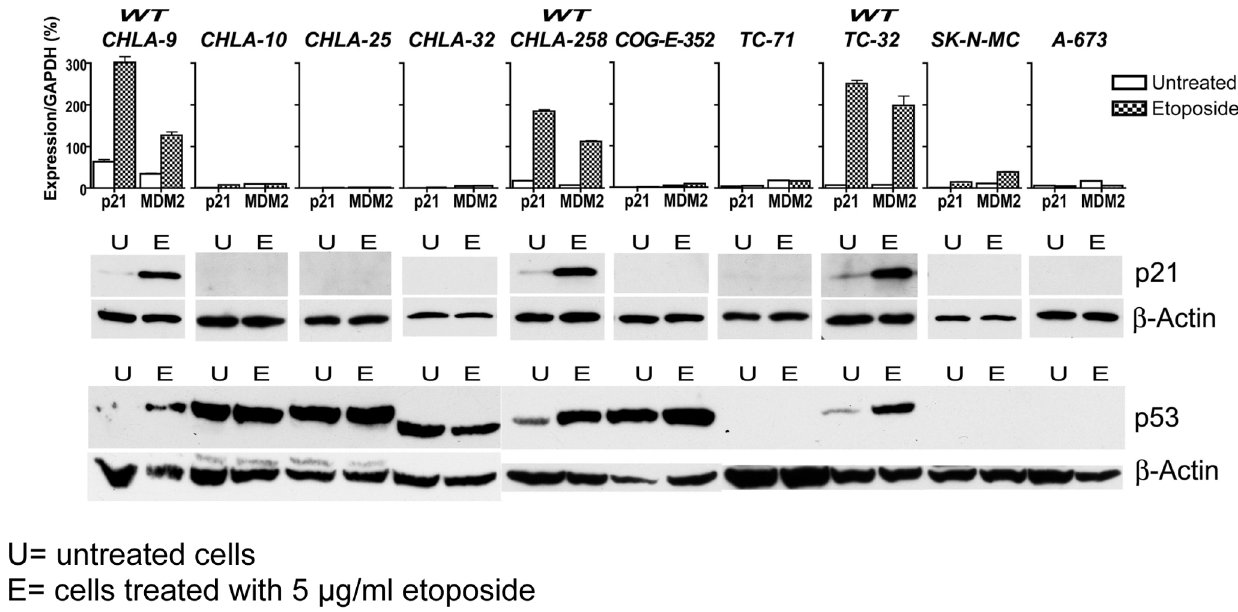
Figure 1. p53 status of EFT cell lines. Functional p53 status was measured by real time pPCR to assess induction of p53 target genes by exposure to etoposide, top panel. These results were corroborated by immunoblot for p21 and p53, lower panels.